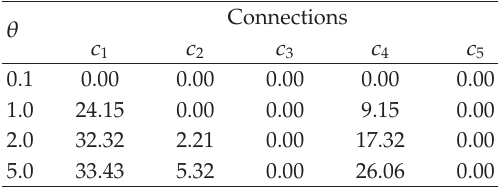
Table 3: The resultant connection overload delay for various θ , in